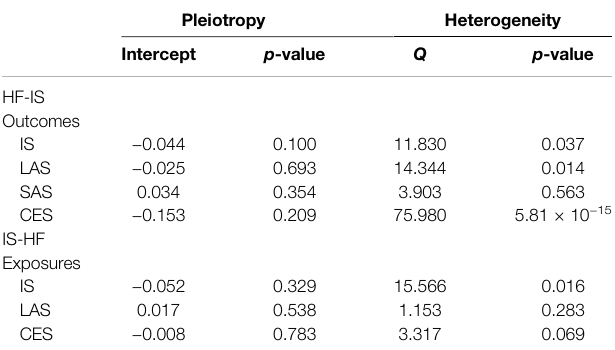
TABLE 2 | Sensitivity analysis of heart failure and ischemic